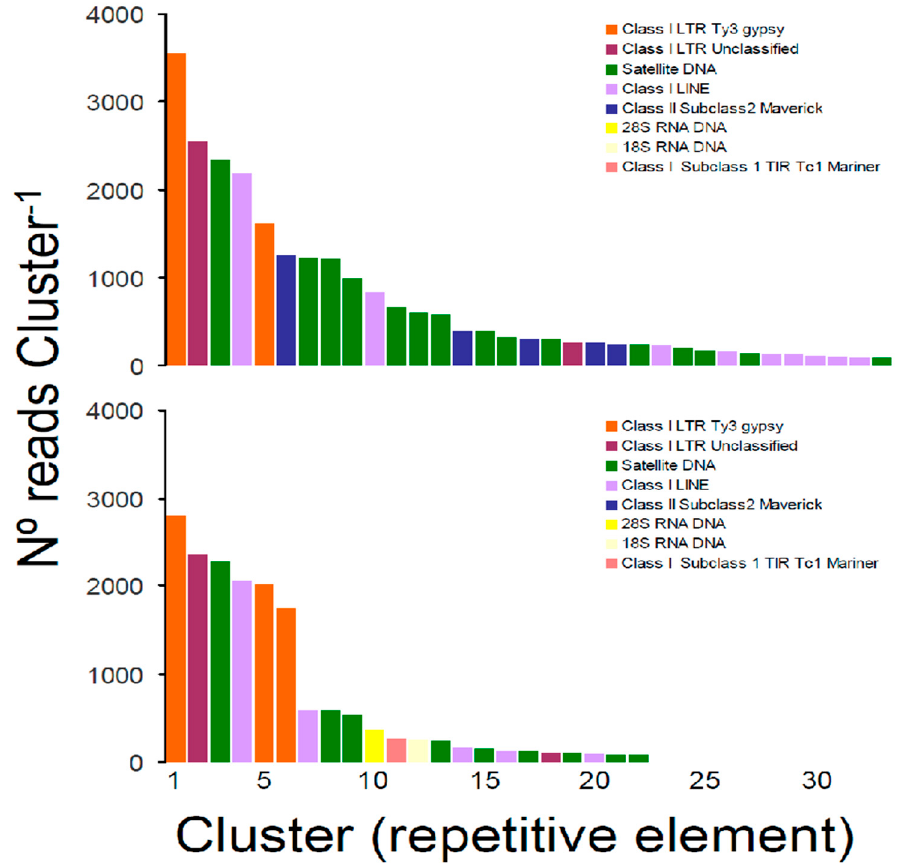
Figure 2. Size distribution and repeat composition of annotated clusters generated by similarity- based partitioning in the boring giant clam Tridacna crocea . Bars are colored according to the type of repeat present in the cluster, as determined by the similarity search in RepeatExplorer2. The first analysis ( top ) was conducted only with non-overlapping reads after contaminant filtering using the program Kraken2. The second analysis ( bottom ) was conducted only with non-overlapping reads but without contaminant filtering. See text for further details.